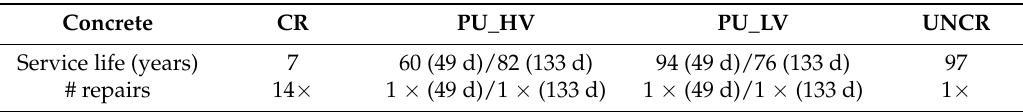
Table 7. Service life prediction and repair frequency for cracked (CR), self-healing (SH) and uncracked (UNCR) concrete in marine environments (exposure class XS2).